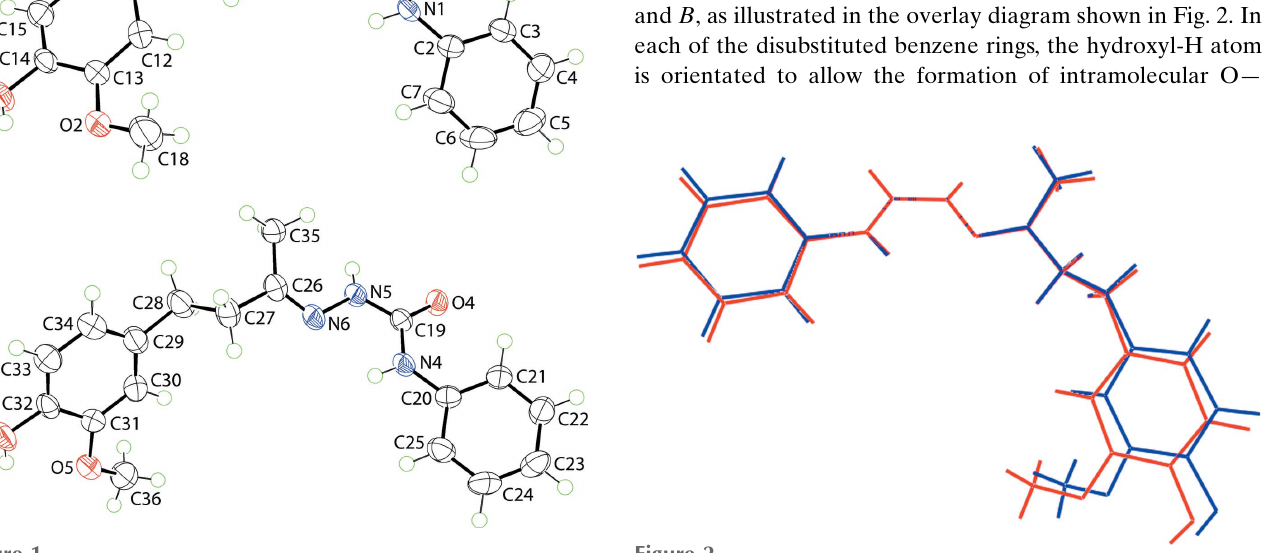
Figure 1 The molecular structures of the two independent molecules comprising the asymmetric unit of (I), showing the atom-labelling scheme and displacement ellipsoids at the 70% probability level.